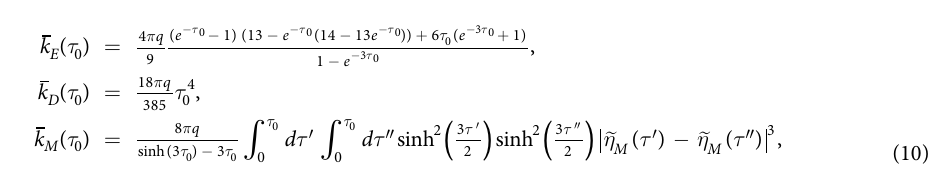
Navigability of Random Geometric Graphs in Lorentzian Manifolds. The navigability of a geomet- node. Starting with the source node, the next node on the path is determined as the node’s neighbor closest to the destination node according to geodesic distances in the manifold. When the closest neighbor has already been visited, the greedy path enters a loop. It does not reach the destination and is thus unsuccessful. This situation occurs when the two nodes forming the loop, also called a local minimum, do not have any third node that would be closer to the destination than the two nodes. The success ratio p s is defined as the fraction of greedy paths which successfully reach their destination, across a given set of source-destination node pairs in the graph. Here stretch of a successful greedy path is the ratio of the length of the path, measured as the number of hops, to the length of the shortest path between the same source and destination in the graph. The average stretch is the aver- age of this quantity across successful paths between a given set of source-destination node pairs. The geodesic distance between a pair of nodes on the underlying manifold is found by integrating the geodesic differential equations: , with μ , ν , ρ = {0, 1, 2, 3}, where x μ ( σ ) = ( t ( σ ), r ( σ ), θ ( σ ), φ ( σ )) is a    + − geodesic curve in four dimensions parameterized by an affine parameter σ , and Γ = with β = {0, 1, 2, 3}, are the Christoffel symbols which specify the affine connections in a curved space. The con- vention of summation over repeating indices is assumed. For a pair of nodes with temporal coordinates t 1 and t 2 and spatial distance ΔΣ 1,2 , the integration of this equation yields the geodesic distance: